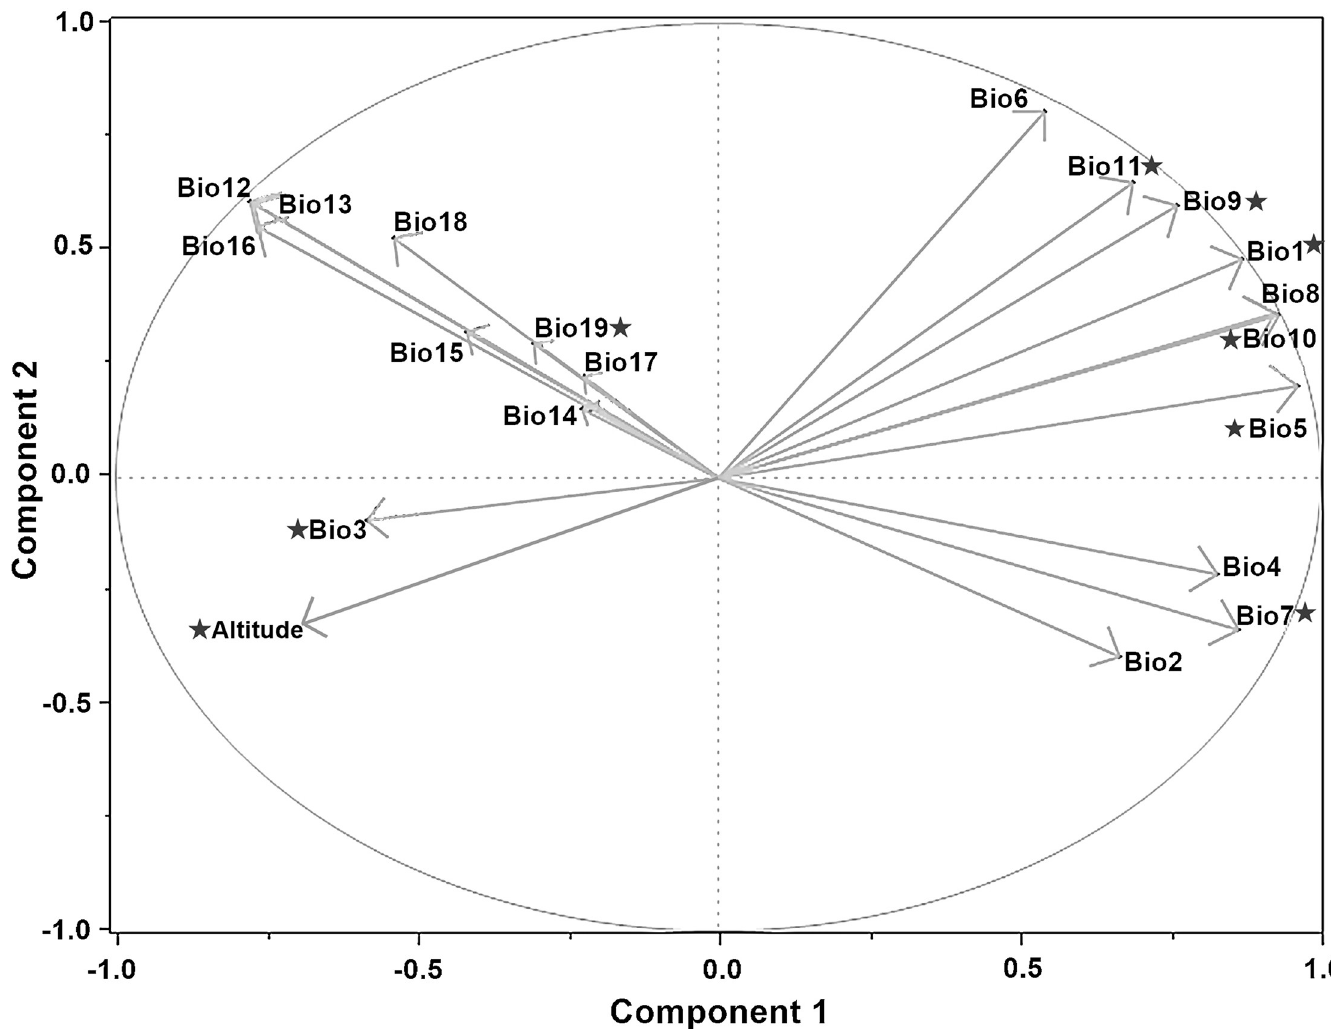
Fig 3. Principal components analysis of the environmental variables and altitude used in the modeling process of P . hartwegii . The symbol “ $ ” indicates the nine variables that further limit the niche breadth.